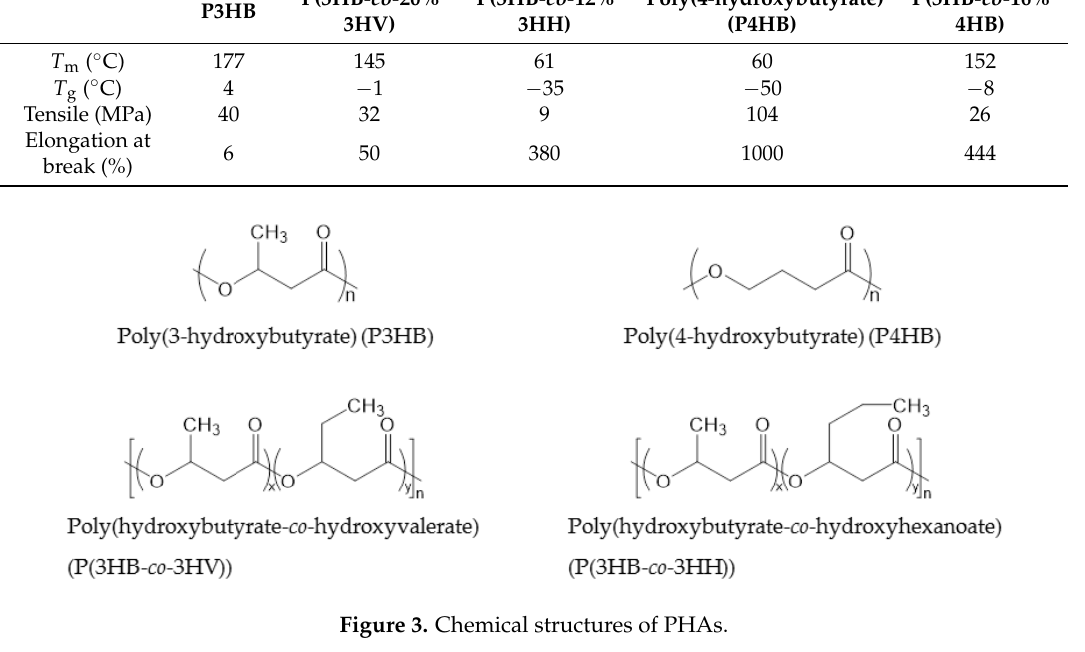
Figure 3. Chemical structures of PHAs.